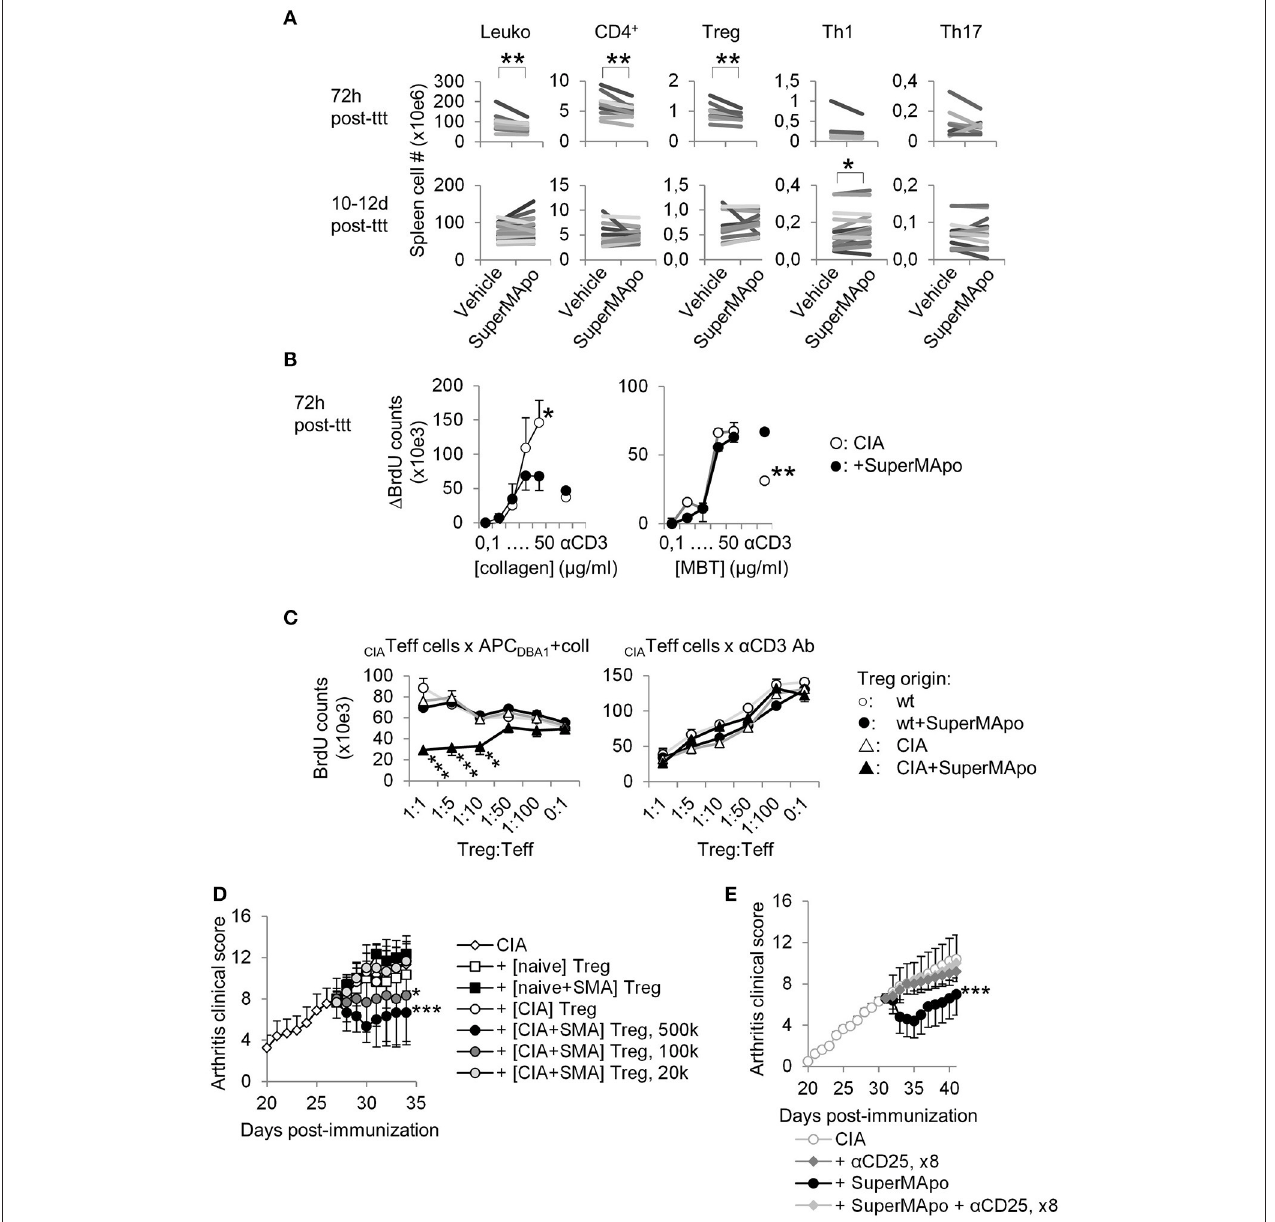
FIGURE 3 | Resolution of arthritis implicates the generation of antigen-specific regulatory T cells. (A) Numbers of splenocytes (Leuko), CD4 + T cells and Treg, IFN- γ + Th1 and IL-17A + Th17 subsets were decreased early after SuperMApo treatment (72h) and were observed normalized 10–12 days post-treatment (10–12 days post-ttt), compared to arthritic mice receiving vehicle. Each bar represents means of each group per one experiment with 5 mice per group. ** P < 0.01, paired t -test. (B) BrdU counts showing the proliferation of cells from arthritic mice 72h after receiving SuperMApo or vehicle, in response to increasing doses of collagen or MBT, or to CD3-specific antibody (used as control). Data are shown as mean ± s.e.m. of mouse spleen cells performed in triplicates, 5 mice per group, * P < 0.05, ** P < 0.01, 2-way ANOVA with Bonferroni post-tests. (C) BrdU counts showing collagen-specific suppression of cell proliferation by Treg issued from arthritic mice treated with SuperMApo 72h earlier compared to Treg from other origins. The suppressive activity of all Treg is also shown as control in CD3-specific antibody-stimulated cultures. Data are shown as mean ± s.e.m. of mouse spleen cells performed in triplicates, 5 mice per group, *** P < 0.001, 2-way ANOVA with Bonferroni post-tests. (D) Arthritis clinical score showing that only Treg issued from arthritic mice treated with SuperMApo ([CIA + SMA] Treg) demonstrated the capacity to reduced arthritis after adoptive transfer compared to Treg from other origins (from CIA mice [CIA], naïve mice receiving SuperMApo [naïve + SMA] or not [naïve]), in a cell number-dependent manner. Five mice per group, mean ± s.e.m., * P < 0.05, *** P < 0.001 vs. CIA group, one-way ANOVA with Bonferroni’s multiple comparison post-tests. (E) Arthritis clinical score showing that CD25-specific depleting antibody injection inhibited SuperMApo-induced arthritis resolution. Five mice per group, mean ± sem, *** P < 0.001 vs. other groups, one-way ANOVA with Bonferroni’s multiple comparison post-tests.